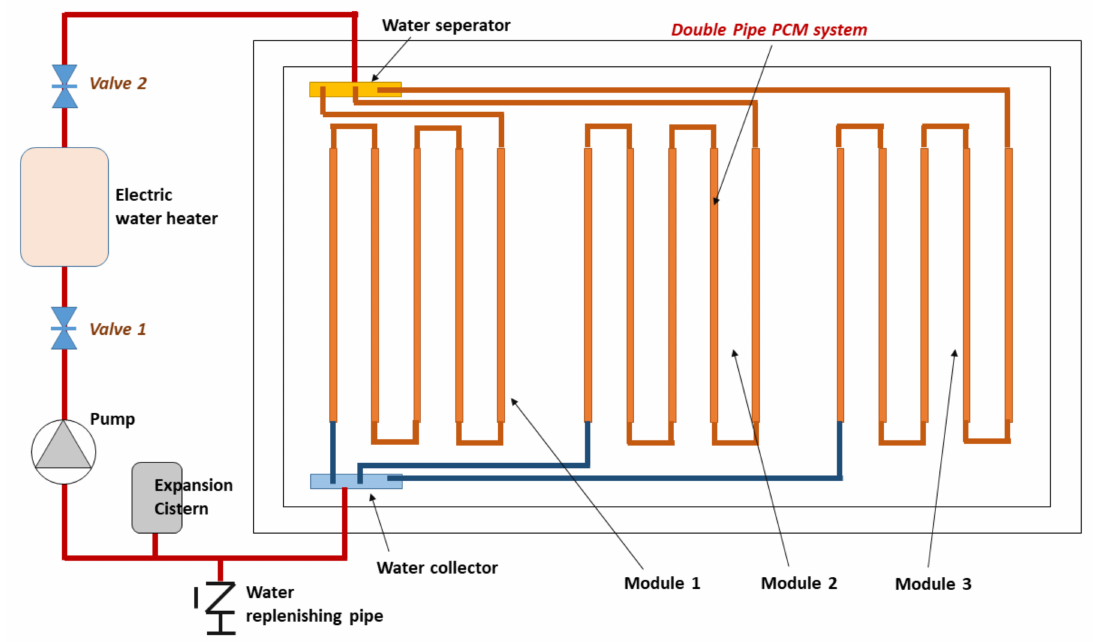
Figure 9. Underfloor double pipe PCM heating system studied by Lu et al.